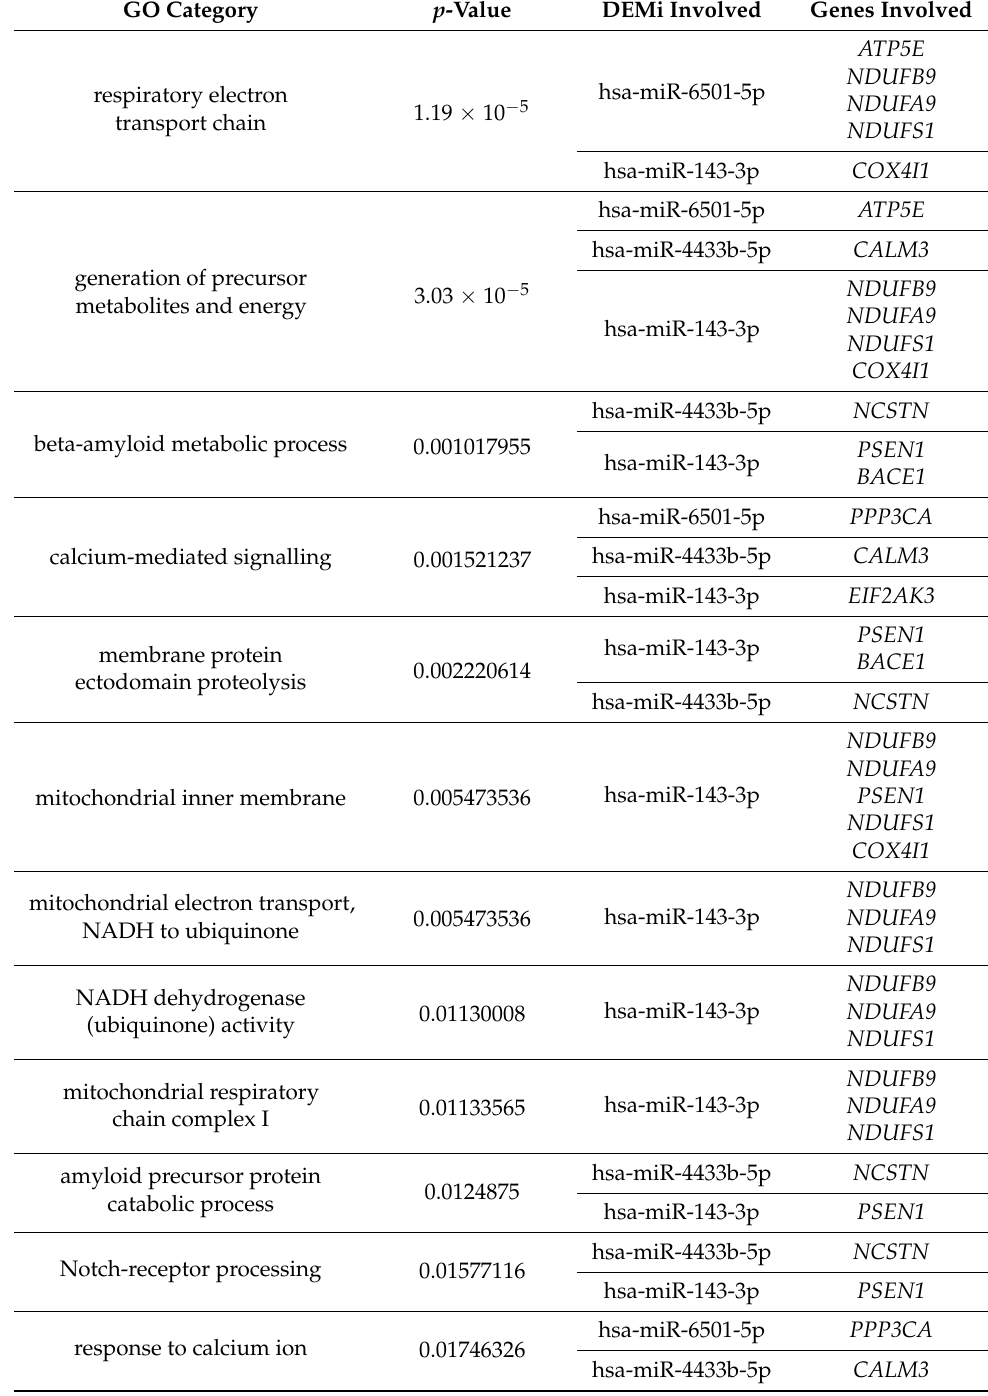
Table 4. GO terms associated with the miRNAs and the respective target